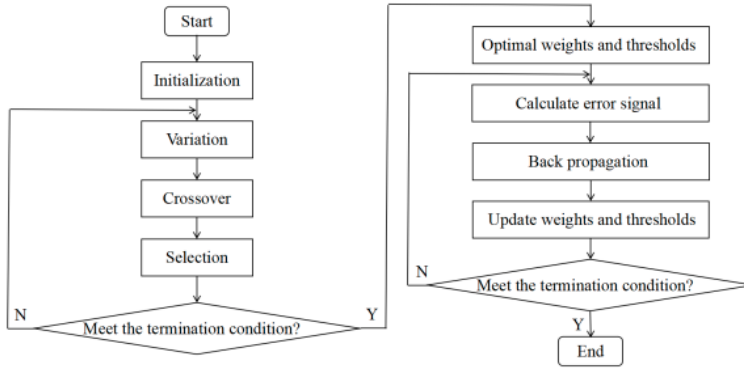
Figure 1. Temperature compensation flow using the DE algorithm.